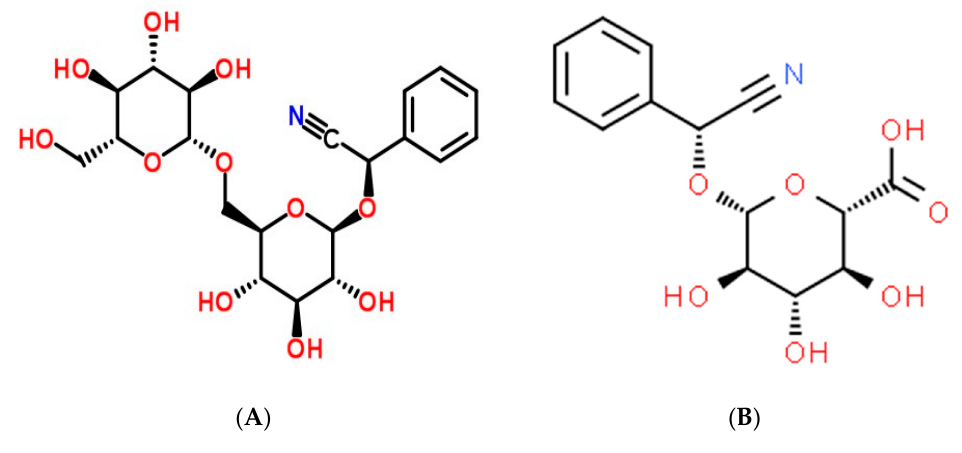
Figure 1. Amygdalin ( A ) and laetrile ( B ) chemical structures.